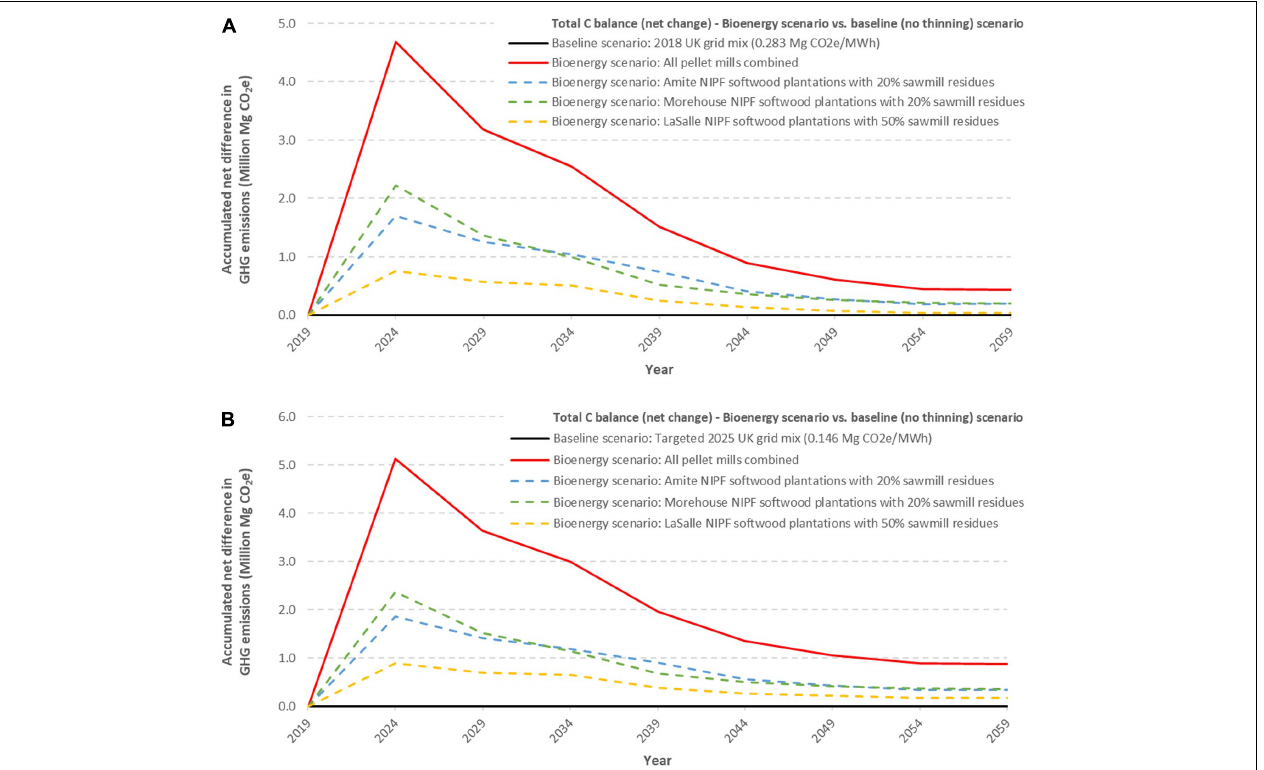
FIGURE 4 | (A) Forest carbon stocks on NIPF pine plantations in the accumulated feedstock supply areas of the three Drax pellet mills under a baseline (no thinnings) and bioenergy scenario. Results are dominated by changes in forest carbon stocks. Forest and wood product carbon stocks for pellet mill specific supply areas follow a similar pattern (see Supplementary Figures 1–3 ). (B) Net difference in GHG emissions of bioenergy vs. baseline scenario combinations. This graph plots the net difference between bioenergy scenarios and the no thinning baseline scenario. While the baseline is associated with net GHG emissions, its GHG emissions are shown as net zero on this graph for ease of display by focusing on the delta between the scenarios. The GHG emission parity time is defined by the point in time when the total accumulated carbon balance over any given time period of the bioenergy scenario first equals the total accumulated carbon balance of the baseline (no-thinning) scenario (i.e., colored lines intersect black line). Since no intersection occurs, GHG emission parity time is not reached for any of the pellet mills.